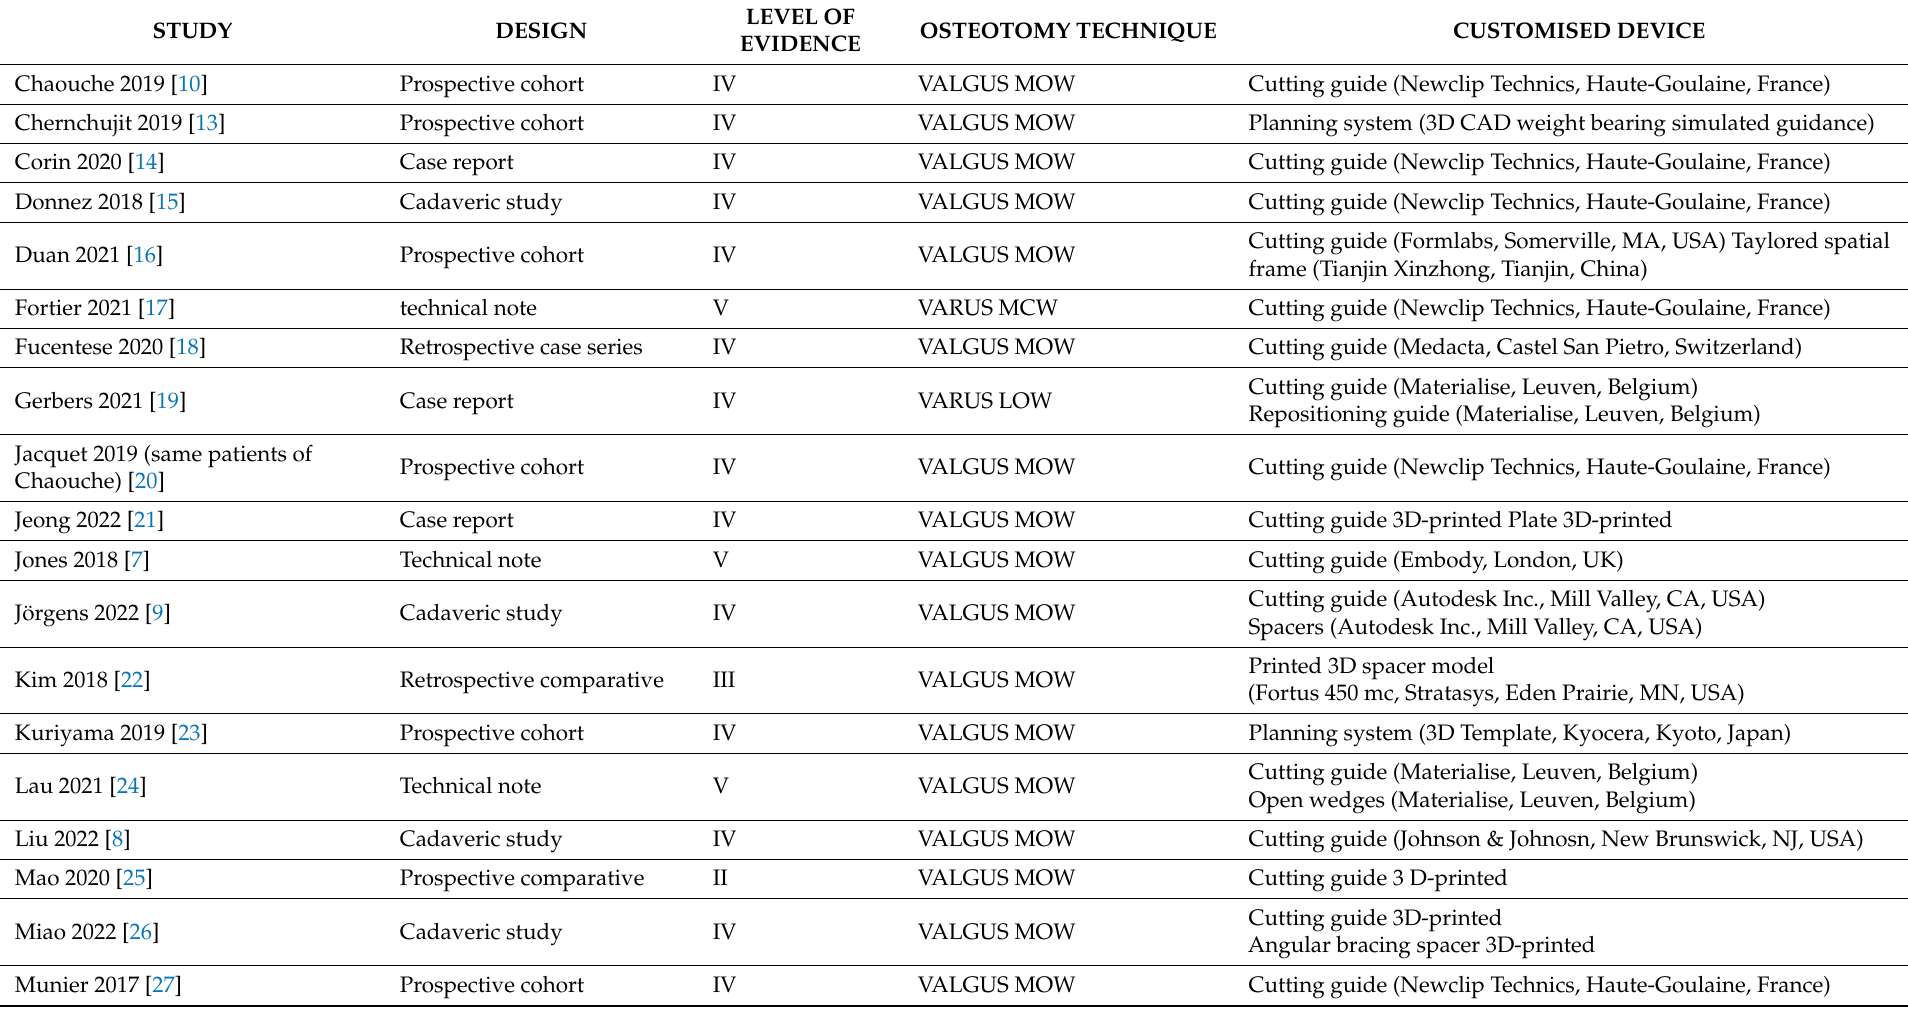
Table 1. Included